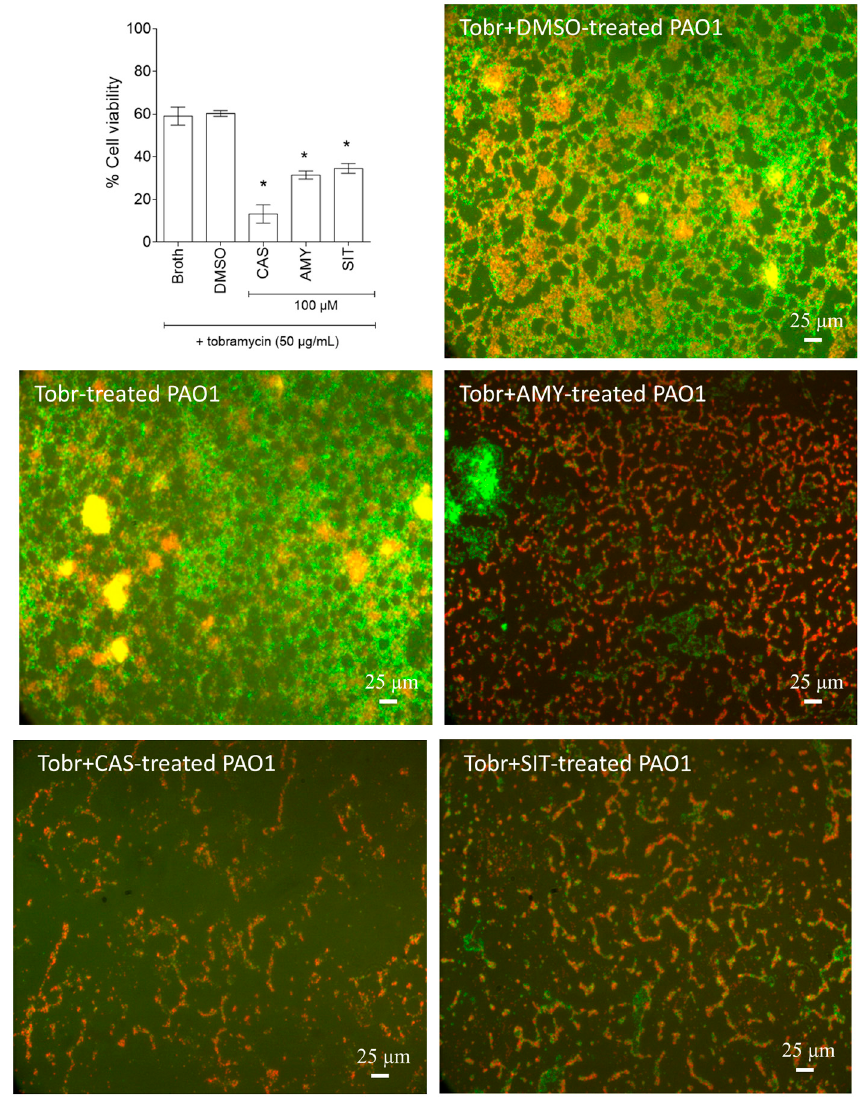
Figure 9. Synergistic activity of cassipourol, β -sitosterol and α -amyrin with tobramycin against biofilm-encapsulated P. aeruginosa PAO1. P. aeruginosa PAO1 cells were incubated statically for 24 h and then treated for 24 h with tobramycin (50 µ g/mL = 107 µ M) alone or with DMSO 1% or cassipourol (100 µ M) or β -sitosterol (100 µ M) or α -amyrin (100 µ M). Assessment of bacterial viability and microscopy were performed as in Figures 6 and 7. Error bars represent the standard errors of the means; all experiments were performed in quintuplicate with three independent assays and asterisks indicate samples that are significantly different from the DMSO (One-way ANOVA followed by Dunnett’s test of multiple comparisons; p <